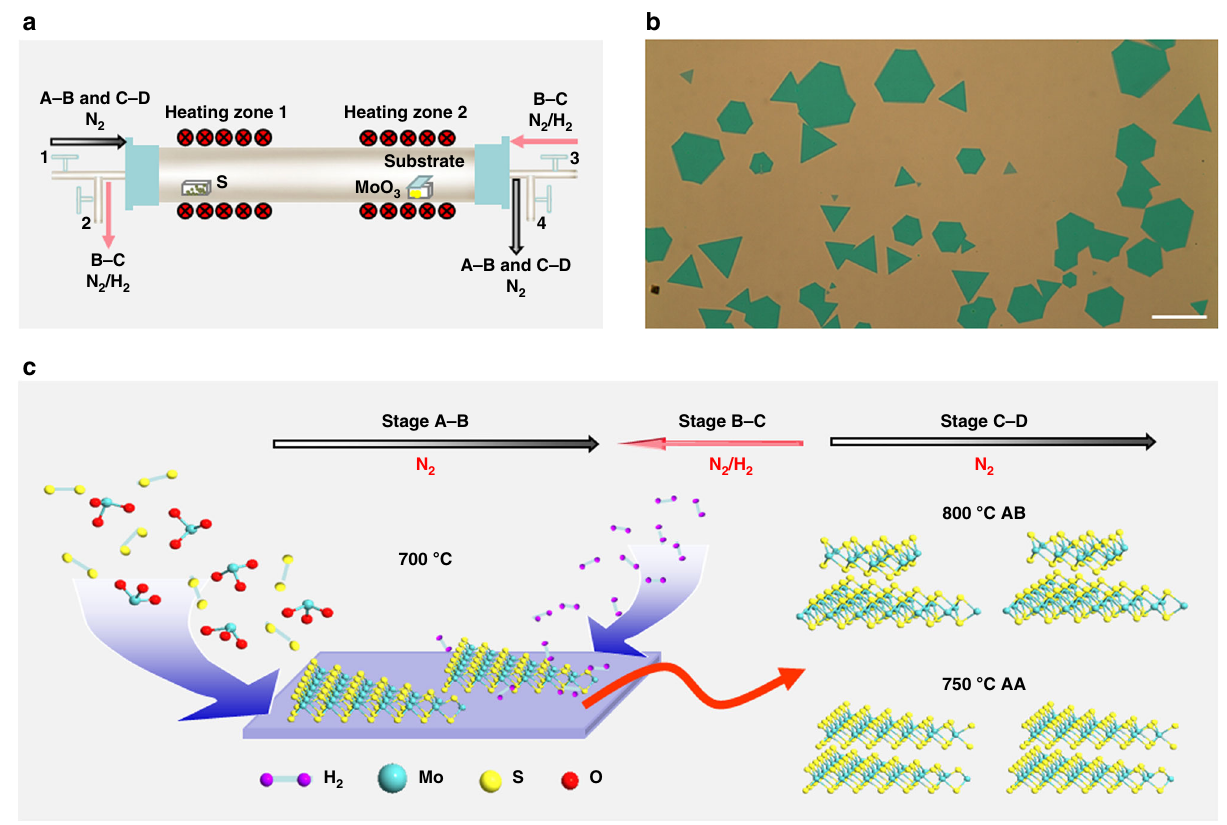
Fig. 1 Reverse- fl ow chemical vapor epitaxy process for bilayer MoS 2 . a Experimental setup of the modi fi ed sequential two-stage thermal CVD process: A-B stage stands for the growth of fi rst layer, C-D stage represents the growth of second layer, while B-C stage corresponds to the growth swing stage for the fi rst and second layers. A reverse N fl ow from the substrate to the source was introduced during the temperature swing stage (B-C stage). b A 2 /H 2 representative optical image of the as-grown bilayer MoS 2 crystal grains. The scale bar is 100 μ m. c Schematic diagram of the reverse- fl ow chemical vapor epitaxy process for bilayer MoS 2 . Different growing temperatures at C-D stage can result in bilayer MoS 2 crystals with different stacking structures: 750 °C for AA stacking bilayer crystals and 800 °C for AB stacking